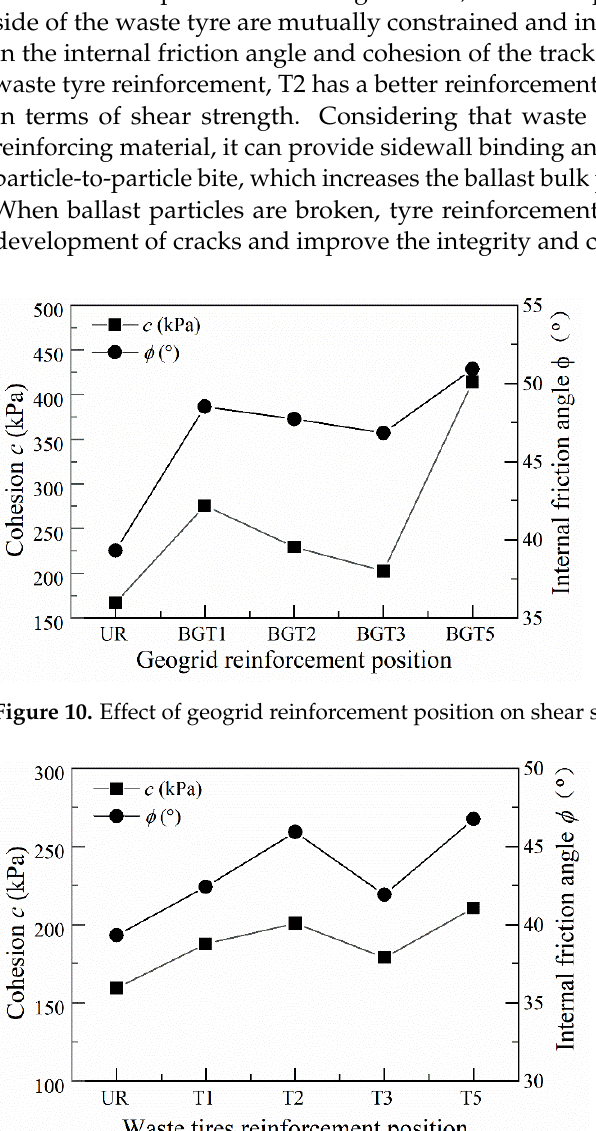
Figure 11. Effect of waste tyre reinforcement position on shear strength.